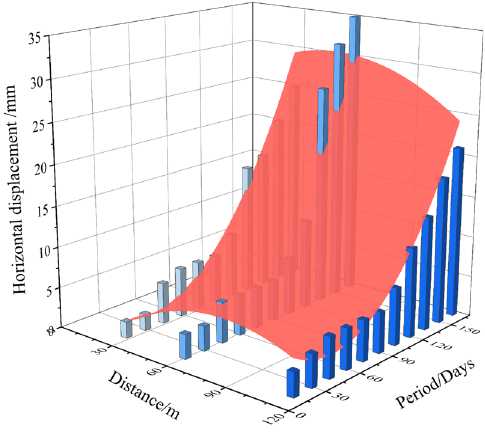
Figure 7: Horizontal displacement fi tting surface of west side.